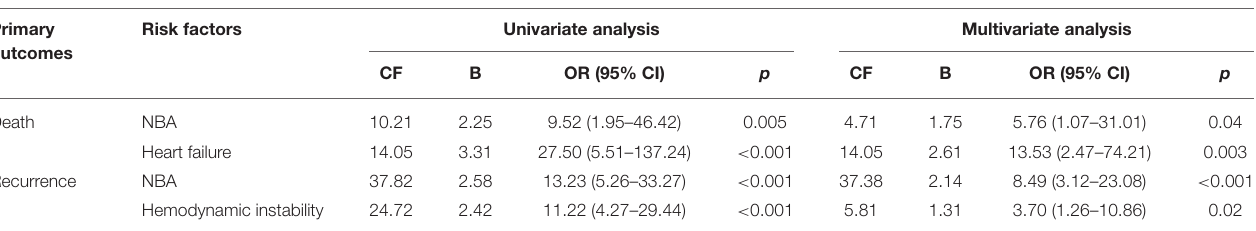
TABLE 2 | Independent risk factors using binary logistic analysis.